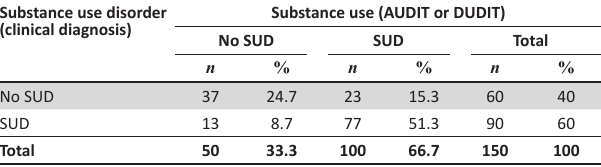
clinical diagnosis of substance use disorders.